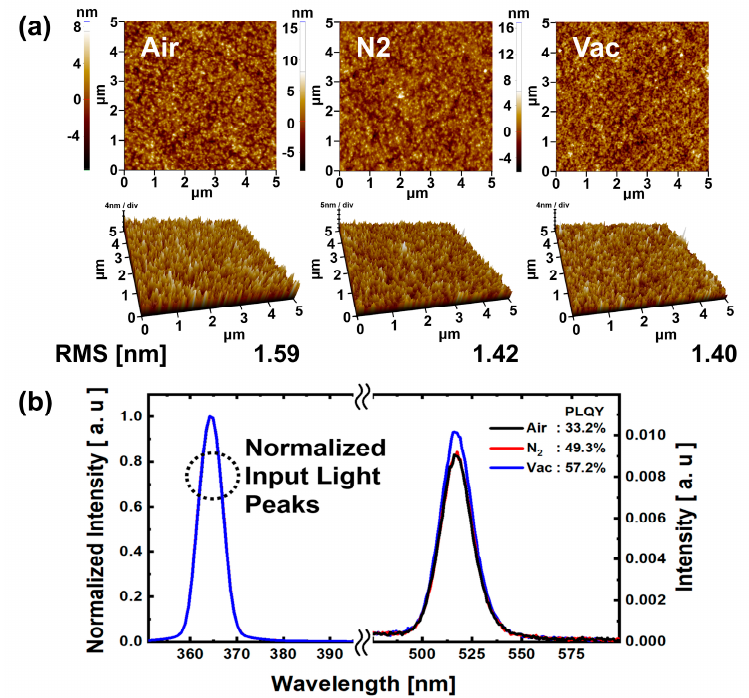
Figure 7. ( a ) AFM images and ( b ) PLQY characteristics of the QD EML pixel surface annealed under air, N 2 , and vacuum atmospheric conditions. air, N 2 , and vacuum atmospheric conditions. Materials 2020 , 13 , x FOR PEER REVIEW